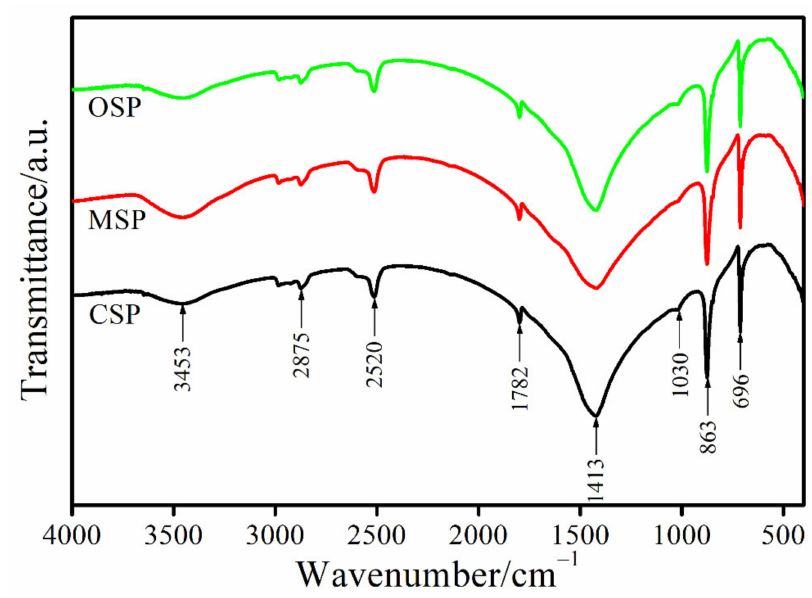
Figure 3. FTIR spectra of the bivalve shell (CSP, MSP and OSP) powders. XRD patterns of the CSP, MSP, and OSP samples are very similar and are exhibited in Figure 4. Bivalve (cockle, mussel, and oyster) shells, biological wastes are primarily made up of calcium carbonate ( ≥ 96wt%) and little contaminations of other chemical contents. It can clearly indicate that the main crystalline phases of the CSP, MSP, and OSP samples are calcite ( β -CaCO 3 ) and minor aragonite are detected for OSP while little vaterite is detected for the other two samples, shown in Figure 4. The diffraction intensity is the calcite (002) 2 θ = 29.81 and the next to strongest are the calcites at (111), (012), (202), (112) (200), and (202), respectively. The XRD analysis verified that the crystalline phase of CaCO 3 in the CSP, MSP, and OSP samples was calcitic polycrystals, which was found to match with the PDF data file of CaCO 3 (PDF no.72–1937) [41,45]. The XRD results are in well agreement with the FTIR data.